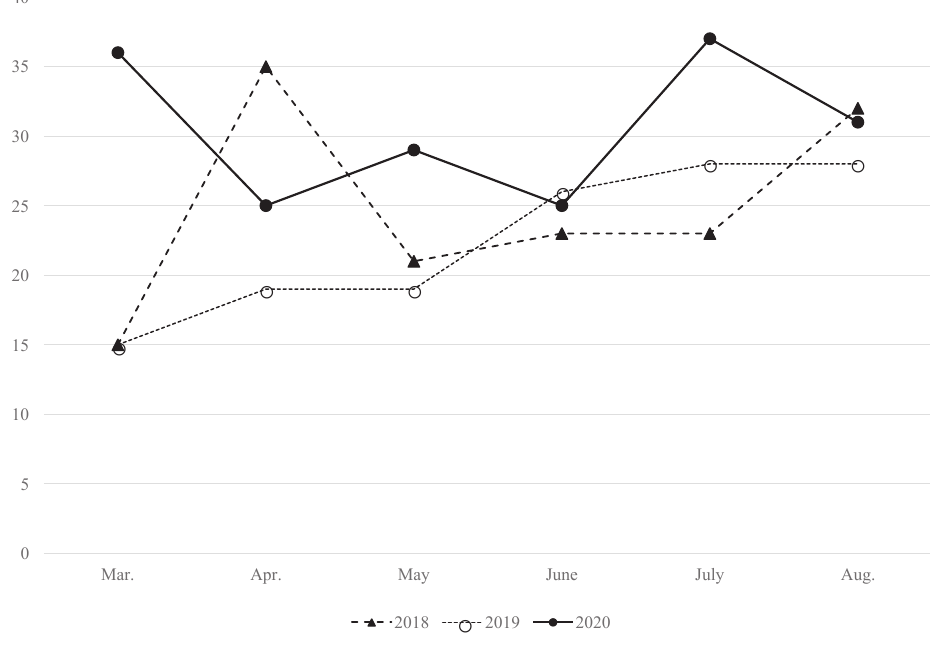
Figure 2. Monthly number of emergency dispatches related to suicide attempts in Okayama City and Kibichuo from March to